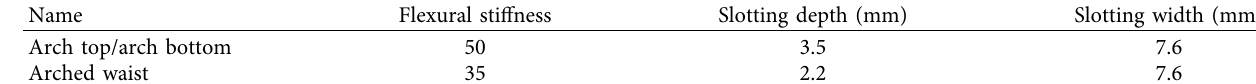
Table 4: Slotting parameters for model splice joints at a 3 ° rounding angle.